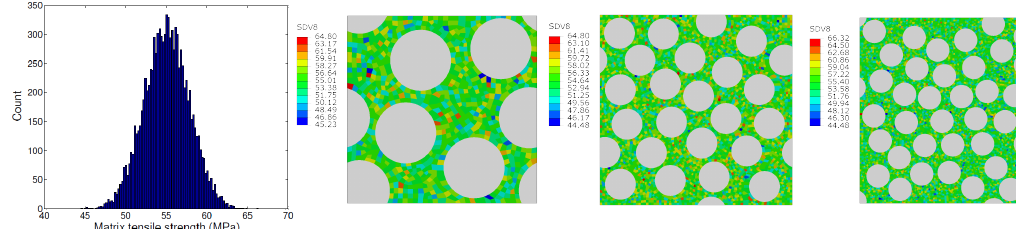
Figure 18. Unit cells with normally distributed tensile strength.